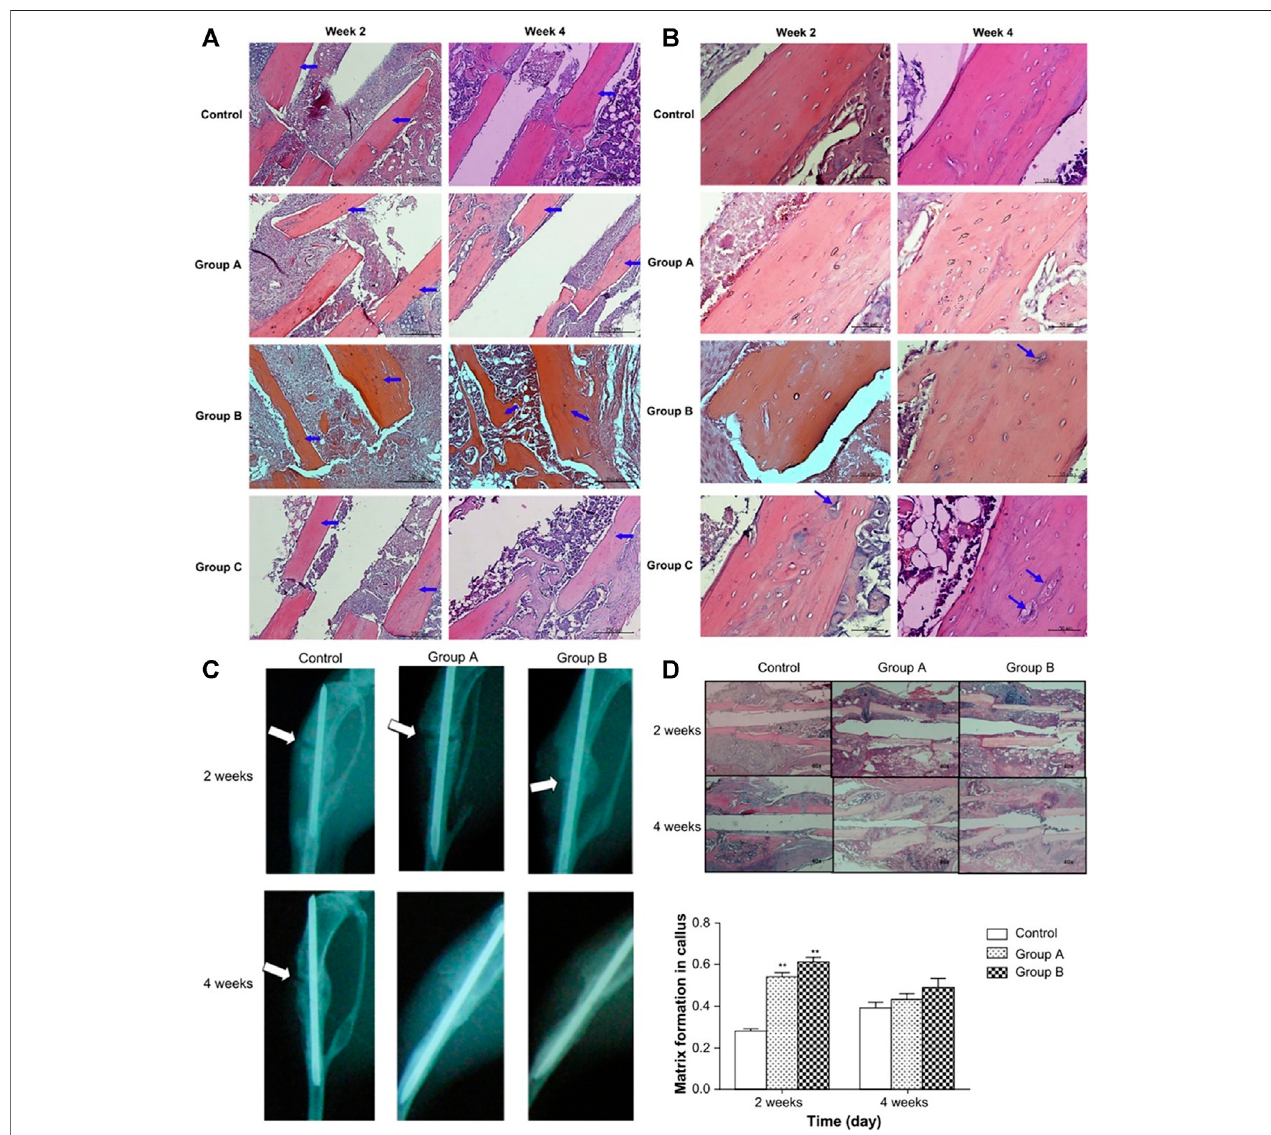
FIGURE 10 | Combination of polymers and bioactive factors. Histological specimens from mice tibias were made after 2 and 4 weeks of implantation of different rhBMP-2 carriers (Group A, Group B, Group C) along with control. Original magni fi cation is 400x for (A) . Original magni fi cation is 100x for (B) . (Group A: 8 mg HAP and 2,500 ng rhBMP-2 within PLGA microspheres, Group B: 1,000 ng rhBMP-2 coating on PLGA microspheres, Group C: 2 mg HAP and 2000 ng rhBMP-2 coating on PLGA microspheres) Blue arrows identify lacunae. (Wang et al., 2009). (C) Radiography of mice tibias 2 and 4 weeks after implantation of SIM/PLGA/HAP.